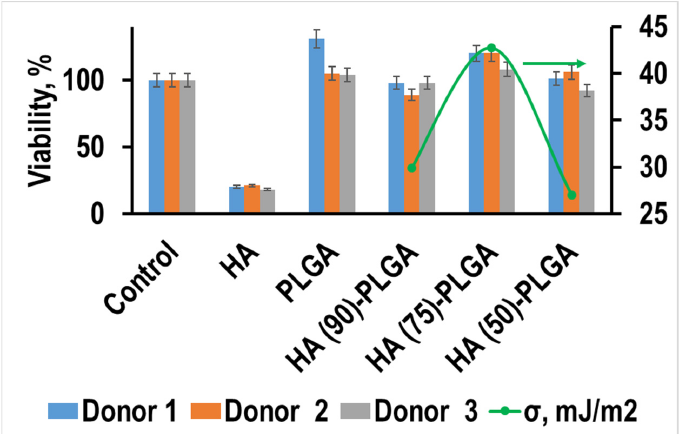
Figure 16. Viability of human macrophages on the 6th day of incubation in the presence of HA-PLGA composites and initial components.